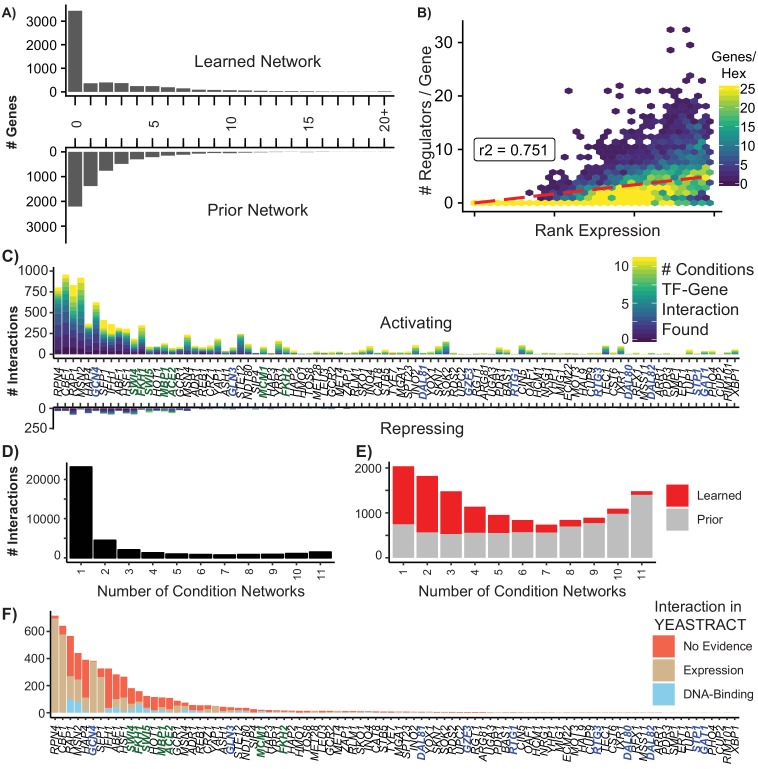
Summary of Learned GRN.(A) Histogram of the number of regulators per target gene in the learned and prior network (B) Hexagonal heatmap of the ranked expression of a gene against the number of regulators for that gene; r2 is calculated using Spearman’s Rank correlation (C) The number of interactions for a TF that are activating (positive) or repressing (negative). Bars are colored by the number of separate conditions in which the interaction is identified, with condition-specific networks selected using a precision threshold of 0.5 (D) The number of unique TF-gene interactions identified in condition-specific networks (E) The distribution of learned and prior interactions from the final, aggregate network in condition-specific networks (F) Evidence for learned network edges which are not in the prior. Interactions where YEASTRACT has evidence for a change in gene expression when the TF is perturbed are in tan. Interactions where YEASTRACT has evidence that the TF physically localizes to the gene are in blue. Interactions where YEASTRACT has no annotated evidence are in red.